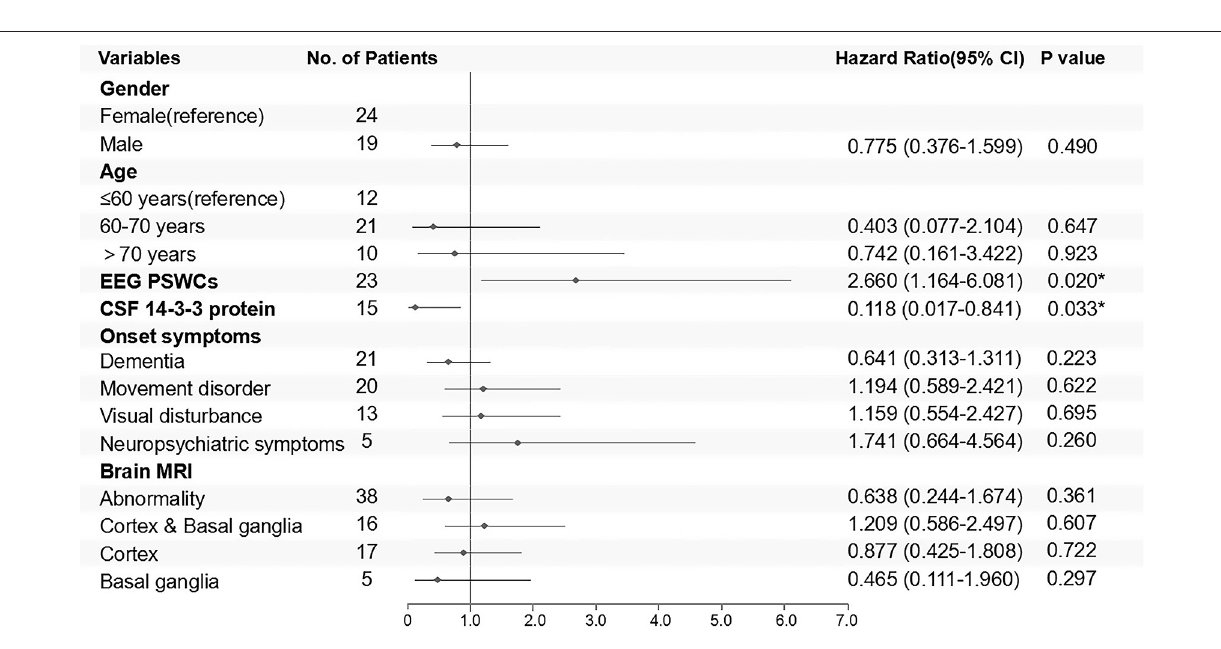
FIGURE 6 | Cox regression model for follow-up patients is shown in the form of a forest plot. Outcomes were classified into survival or death 1 year after disease onset. Negative results of ancillary test were taken as